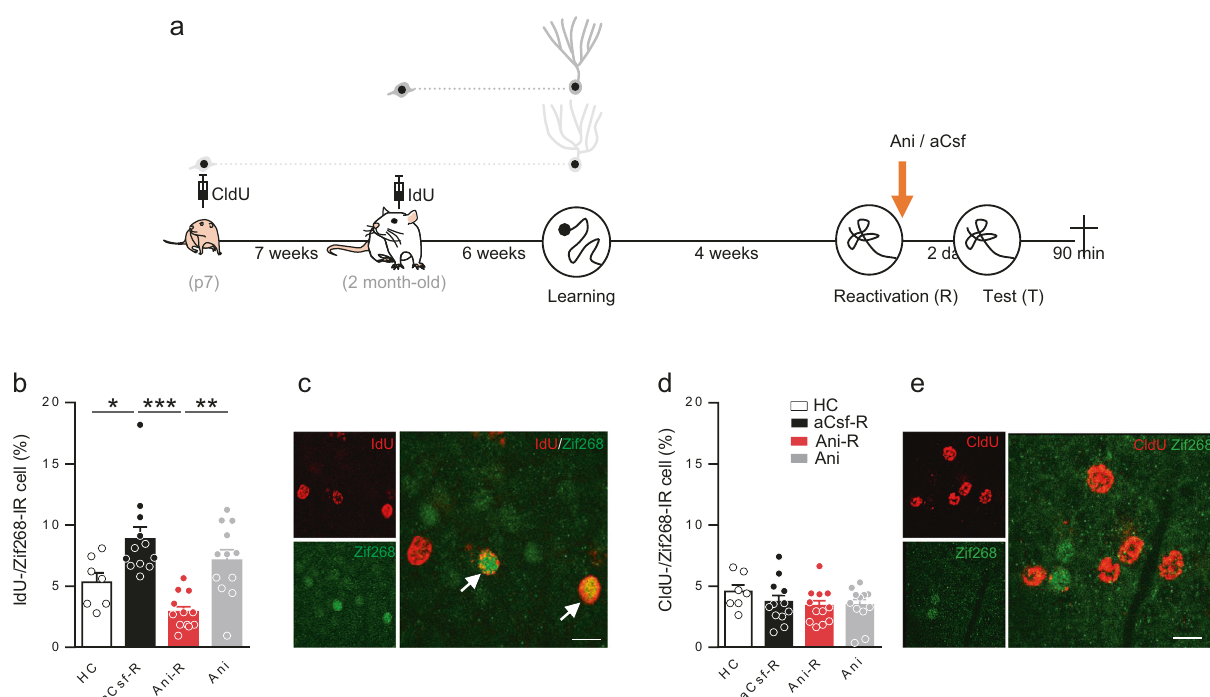
Fig. 2 The effect of reconsolidation blockade on retrieval-induced activation is speci fi c to adult-born neurons and not to developmentally-generated cells. a Experimental protocol: 7-days-old rat pups were injected with CldU and later with Idu at the age of 2-month old. Six weeks later, they were trained for 6 days in the MWM and memory was reactivated 4 weeks later. Immediately after reactivation rats are injected (icv) with anisomycin (Ani-R, n = 12) or with aCsf (aCsf-R, n = 12). A group of rats received anisomycin without the reactivation session (Ani, n = 12). Memory was tested 2 days later and rats were sacri fi ced 90 min after the test. b Zif268 expression in IdU-IR cells. Percentage of expression was higher in the aCsf-R group compared to that of control home cage (HC) rats ( n = 7) and to that of Ani-R rats (Tukey ’ s test * p < 0.05, ** p < 0.01, *** p < 0.001) but not different than that of Ani rats. c Confocal illustration showing IdU-IR cells (red) coexpressing the cellular activation factor Zif268-IR (green). Bar scale 10 µ m. d Zif268 expression in CldU- IR cells. Percentage of expression was similar among the groups. e Confocal illustration showing CldU-IR cells (red) coexpressing the cellular activation factor Zif268-IR (green). Bar scale 10 µ m. All data shown are mean ± s.e.m. For statistical details, see Table